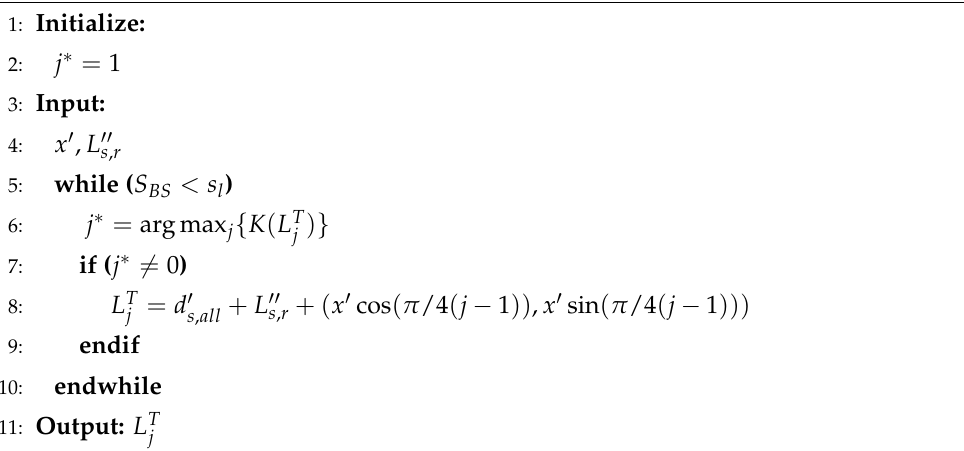
Algorithm 2 RS location for throughput